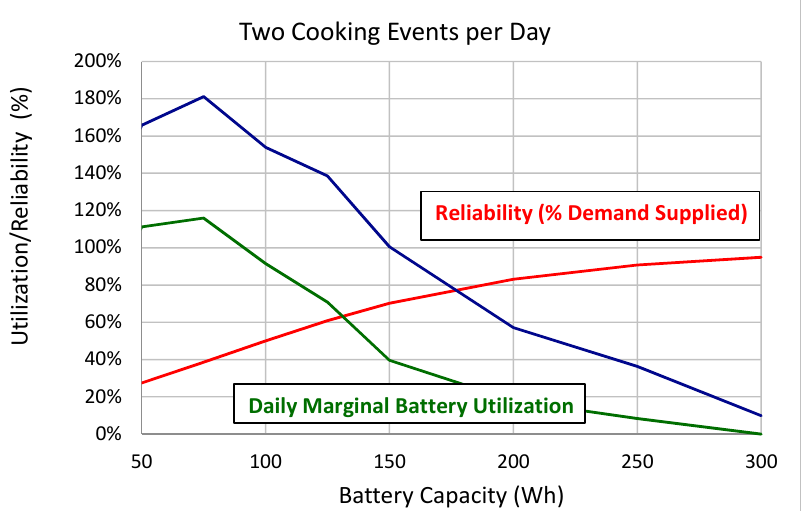
Figure 8. Marginal battery utilization efficiency and demand reliability as a function of battery capacity in a DDS LTO SEC system. Two types of battery utilization efficiency are illustrated. The upper curve is the incremental Wh of total daily battery output divided by the incremental Wh of battery capacity. The lower curve is the incremental of newly utilized solar panel output (i.e., total output minus the Wh diverted from DDS loads) divided by the incremental Wh of battery capacity. Net newly utilized electricity represents additional DDS LTO SEC energy consumption that is enabled by the incremental increase in battery capacity with no increase in solar panel capacity. The supply of the 250 Wh/event demand (i.e., 500 Wh/day) is 80% reliable when the battery capacity is above 200